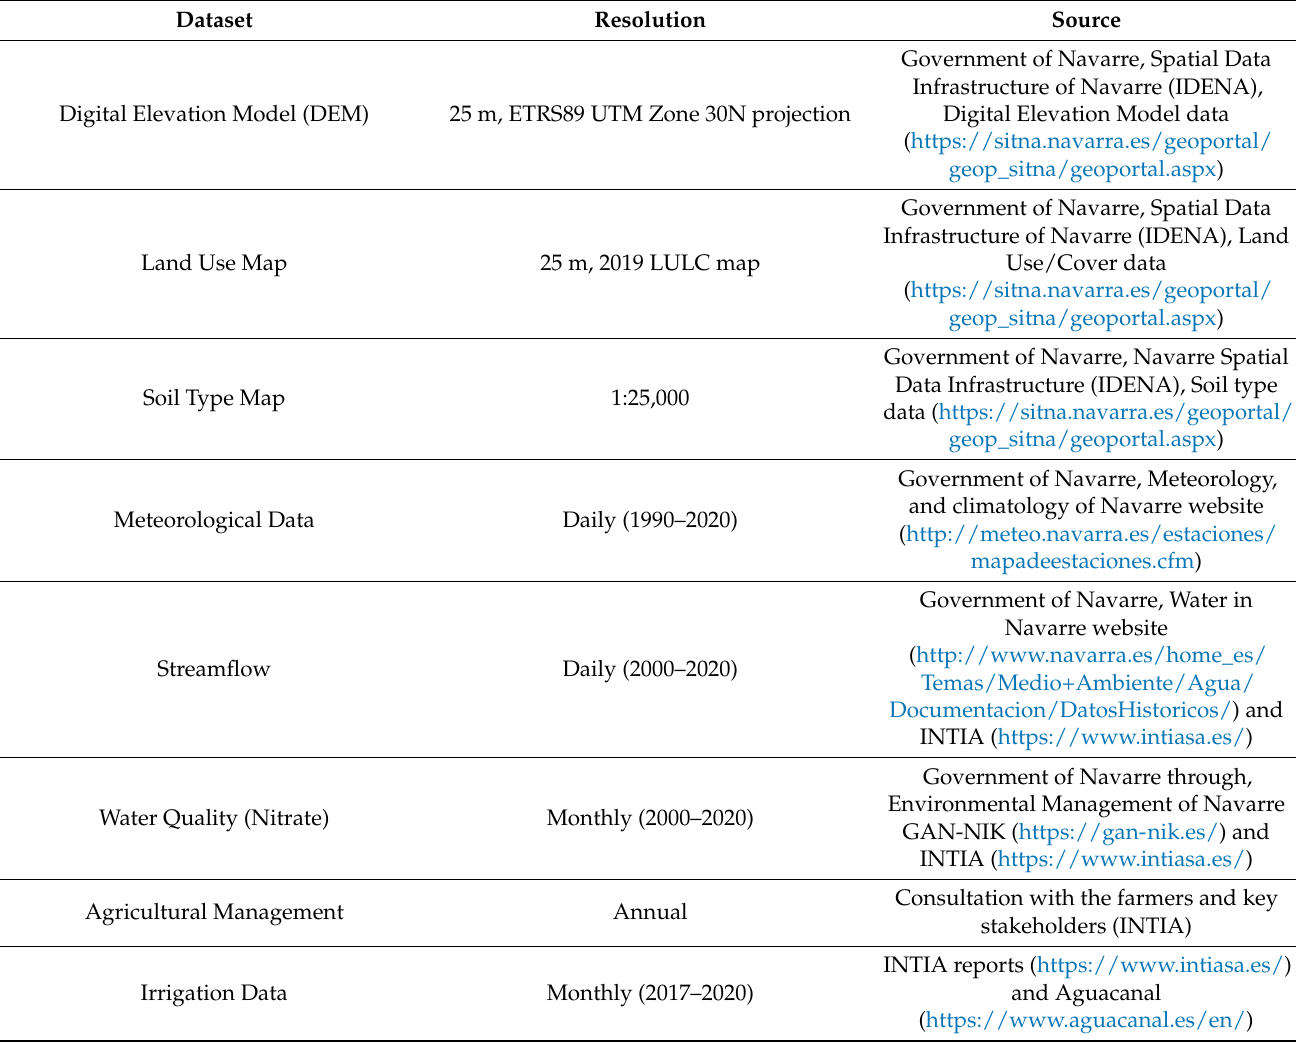
Table 2. The SWAT model input data requirement and their